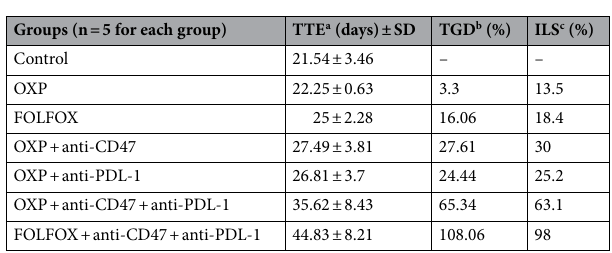
Table 1. Therapeutic efficacy data of therapeutic and control group mice bearing CT-26 tumor. a Time to reach end point. b Tumor growth delay. c Increase Life